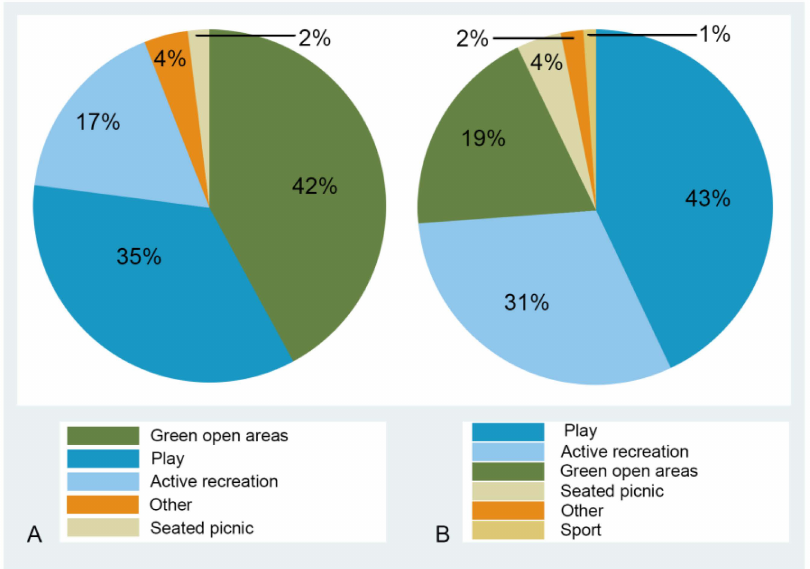
Figure 2. Use of park facilities in ( A ) comparison parks ( n = 1432) and ( B ) intervention parks ( n = 2519).